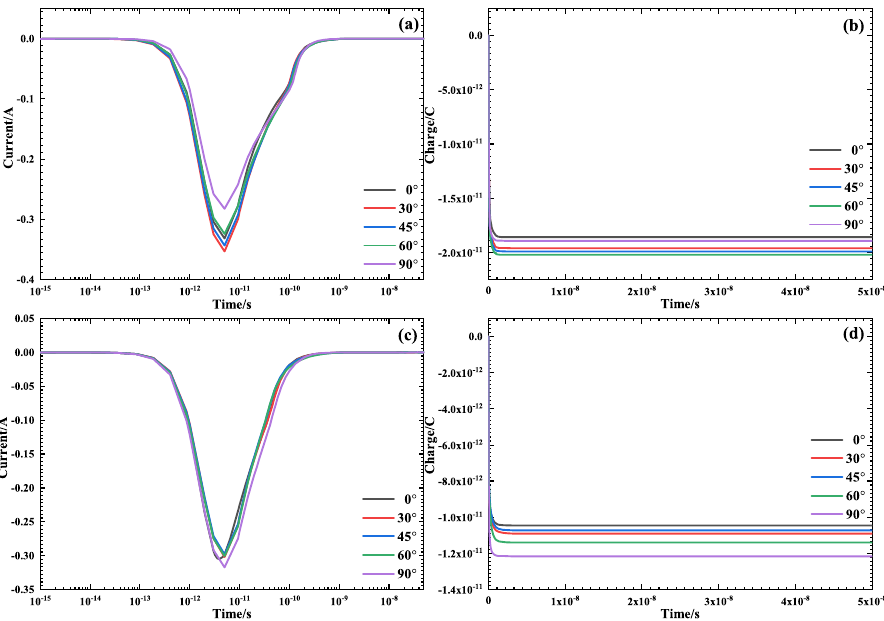
Figure 6. The current and collected charge change in the base with time as heavy ions irradiates the center of emitter ( a , b ) and base ( c , d ) of the SiGe